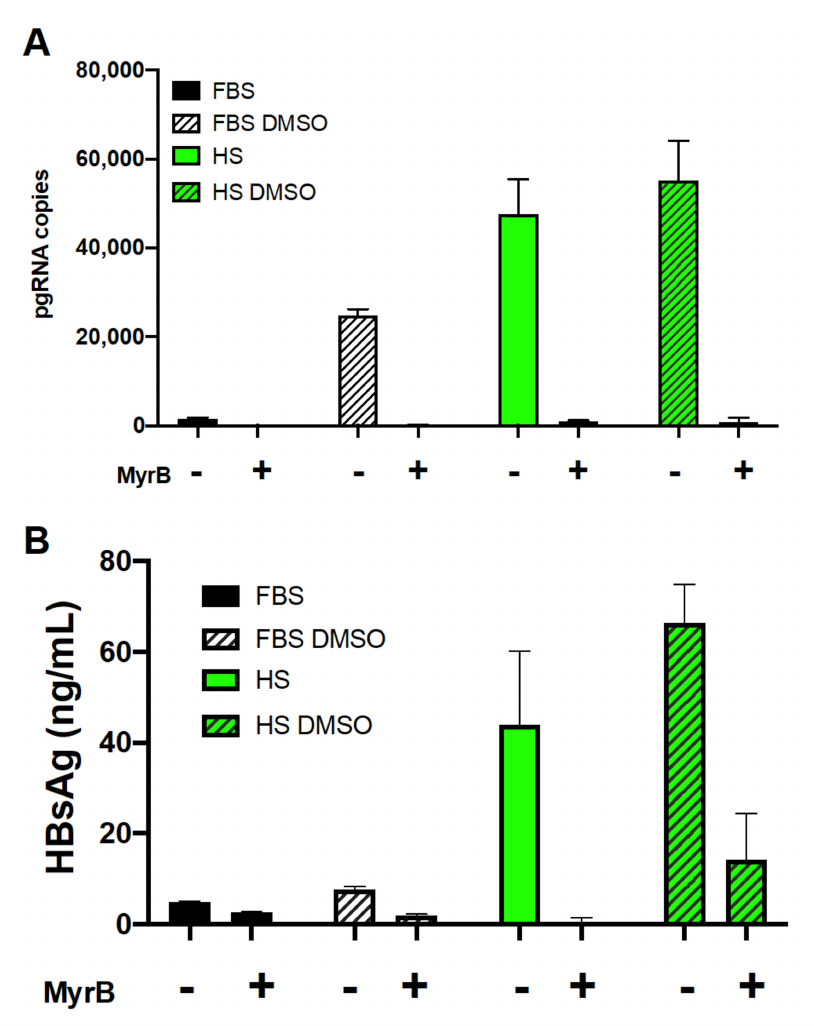
Figure 5. Reduction of HBV infection by MyrB, an entry inhibitor. MyrB was added to culture at 300 nM 30 min prior to infection and remained during HBV infection and one day post-infection. Cell monolayers and the culture supernatant were collected on day 7 post-infection for ( A ) RT-qPCR analysis of pgRNA and ( B ) ELISA of the surface antigen (HBsAg). Average values with error bars ( ± SD) derived from three experiments are